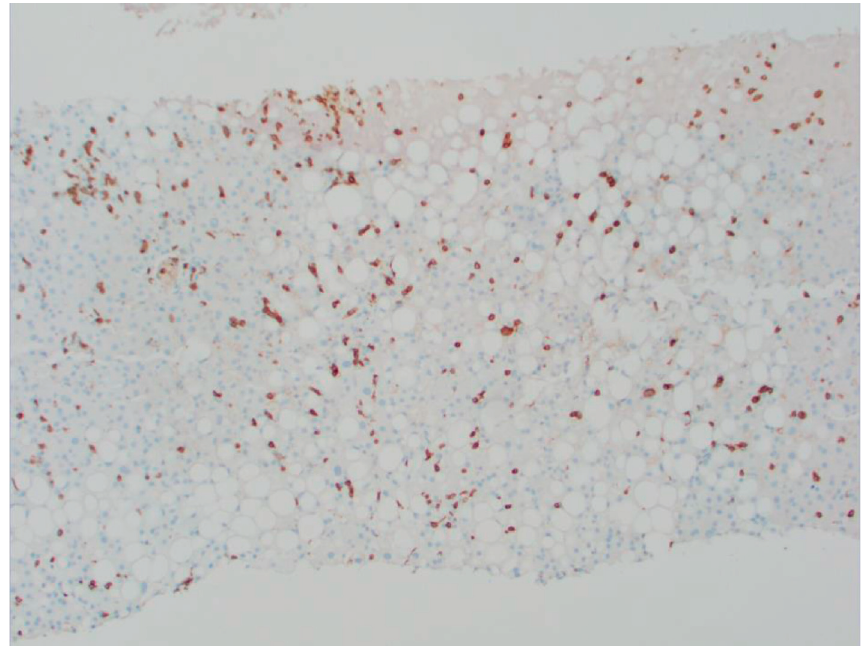
Figure 4: Immunohistochemical staining of CD3-positive T-lymphocytes (brown stain) in the liver. An excessive number of T-lymphocytes are in